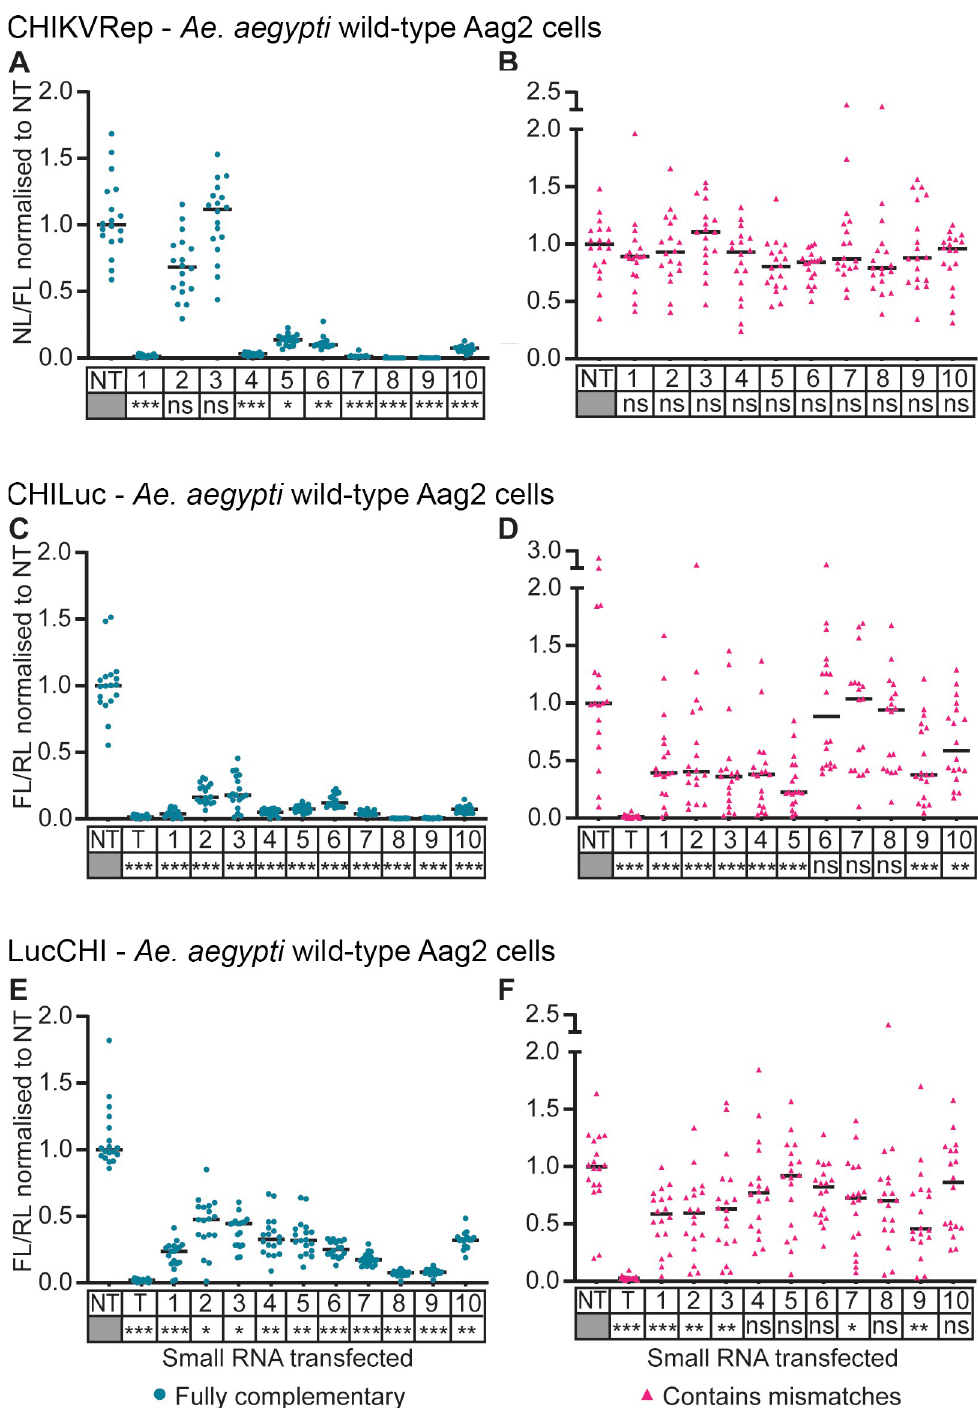
Fig 2. Effect of small RNAs on expression of a CHIKV split replication system and different reporter systems containing viral sequences in Ae . aegypti wild-type Aag2 cells. Plasmids expressing selected shRNA-like small RNAs (Fully complementary, blue) or miRNA-like small RNAs (Contains mismatches, pink) were co-transfected with a split replication system with nanoluciferase (NL) under the control of a CHIKV subgenomic promoter, and a plasmid expressing firefly luciferase (FL) as control for transfection efficiency ( A, B ); a chimeric CHILuc reporter containing the target sequence within the protein coding region ( C, D ); or a LucCHI reporter which has the target sequence in the 3’ UTR ( E, F ). A plasmid expressing Renilla luciferase (RL) as control for transfection efficiency was used in C-F, as well as